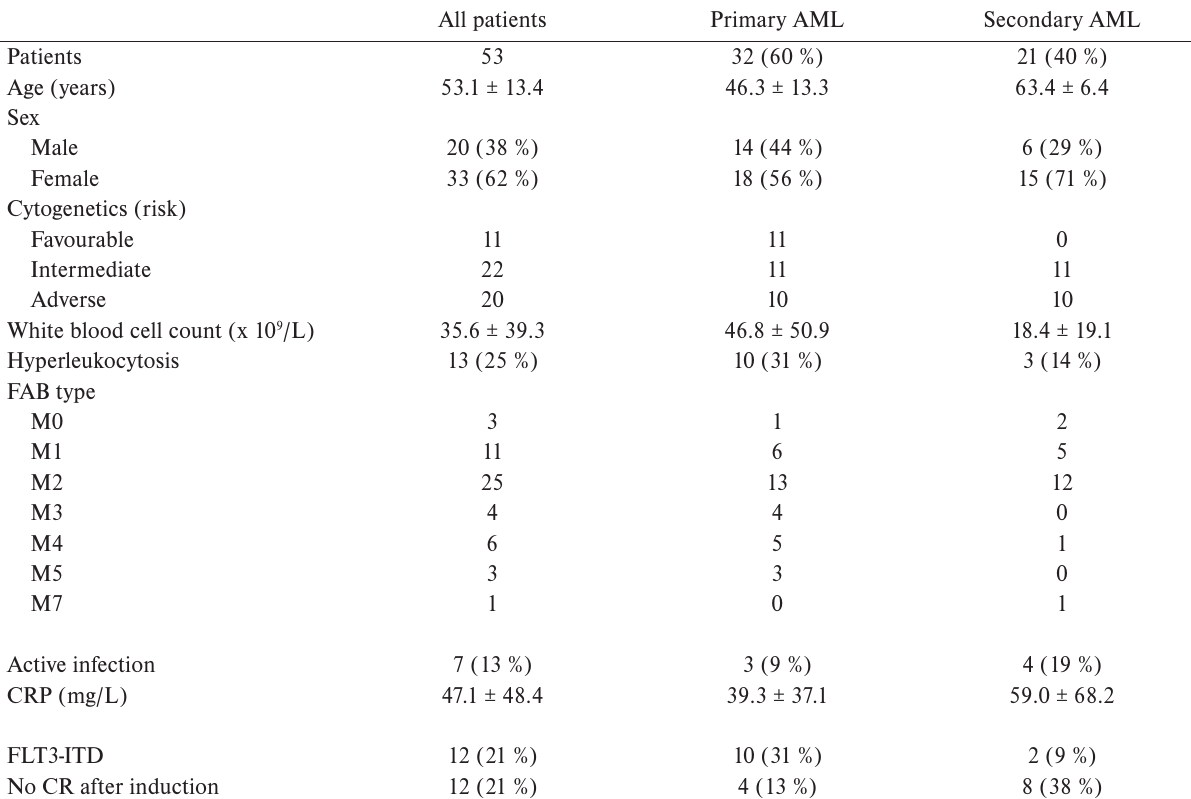
Table 1. Characteristics of